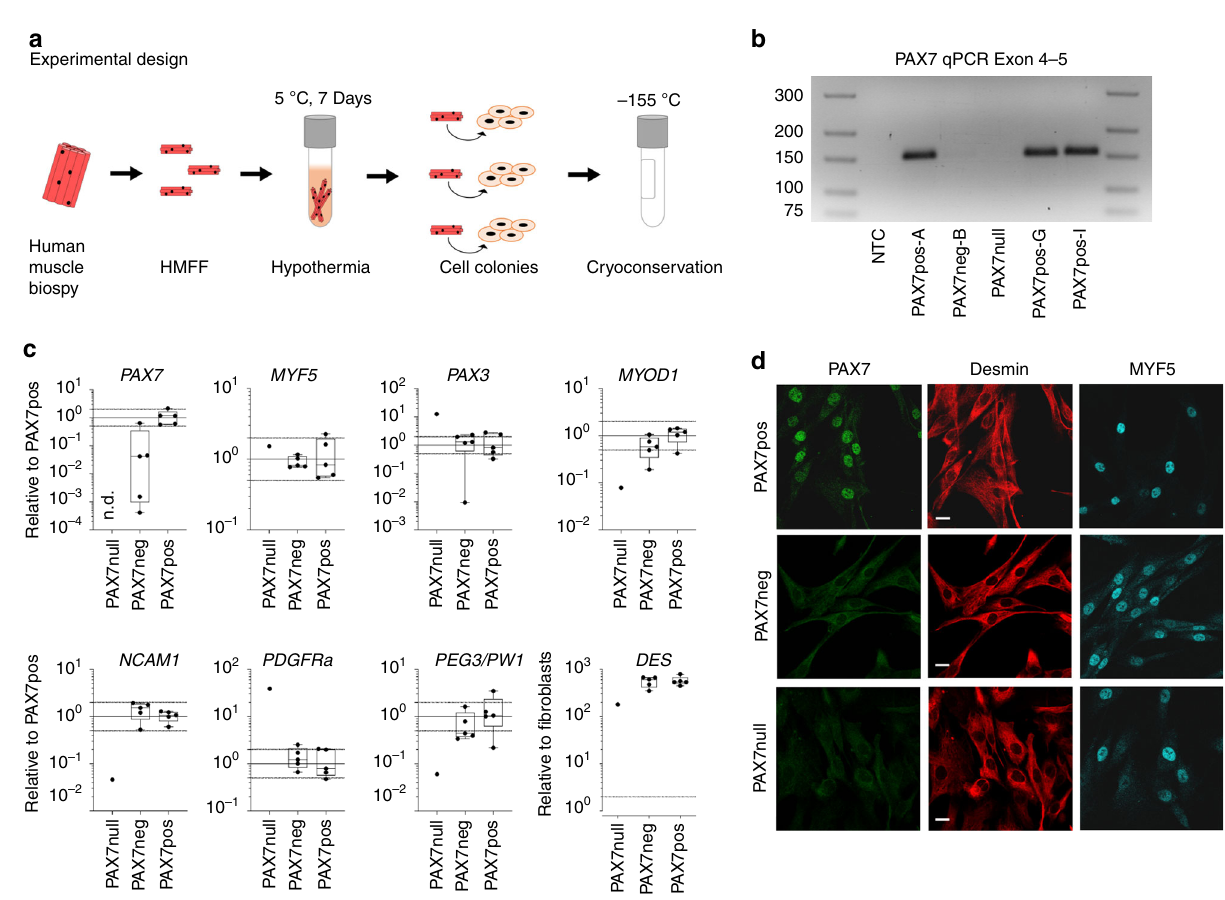
Fig. 1 Characterization of human desmin-positive, PAX7- negative cell populations. a Experimental design. Cell colonies grow out of human muscle fi ber fragments (HMFF) within 3 weeks after hypothermic treatment. b Absence of PAX7 transcripts in PAX7null cells. The PAX7 c.86-1G > A mutation in PAX7null cells leads to deletion of exon 2 and a premature stop codon in exon 3. The PCR primers shown here recognize exons 4 and 5. PAX7neg-B cells are derived from donors with intact Pax7 gene and also do not express PAX7 . c Expression of markers of myogenic and interstitial cells assessed by qPCR in PAX7null, PAX7neg, and PAX7pos cell colonies. All data were normalized to two reference genes and relativized to the mean of PAX7pos cells. The dotted line at twofold and 0.5-fold represents our threshold for differential expression. d Myogenic cells derived from HMFFs were stained for PAX7, desmin, and MYF5. PAX7-negative populations (PAX7null, PAX7neg) show no speci fi c signal for PAX7 in immuno fl uorescence stainings. Cell lines are described in Supplementary Table 2. Scale bars: 20 µ